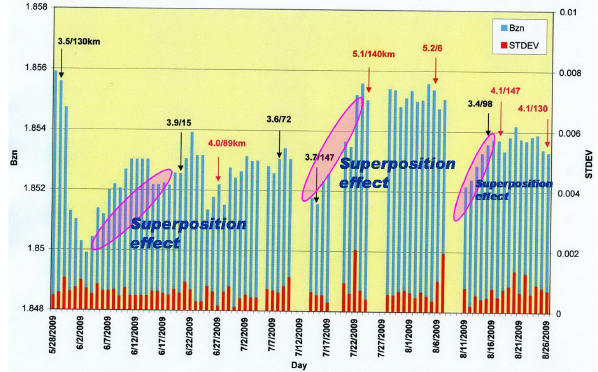
Fig. 6 Fig. 6. Bzn and STDEV distributions at the GOPS, within the inter- val 28 May–26 August 2009; vertical arrows are earthquakes; ratio 5.1/140 is the magnitude/hypocentre depth of earthquake.